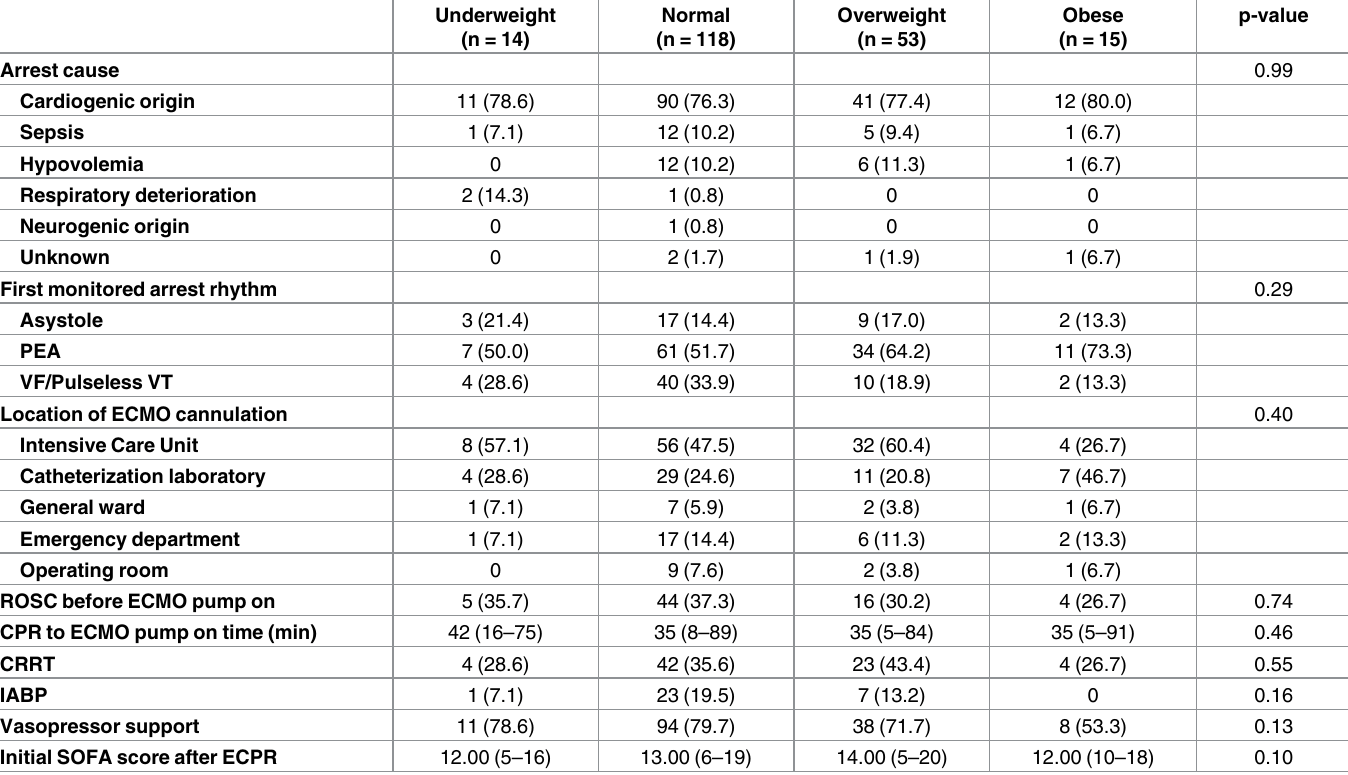
Table 2. Arrest and procedural characteristics.